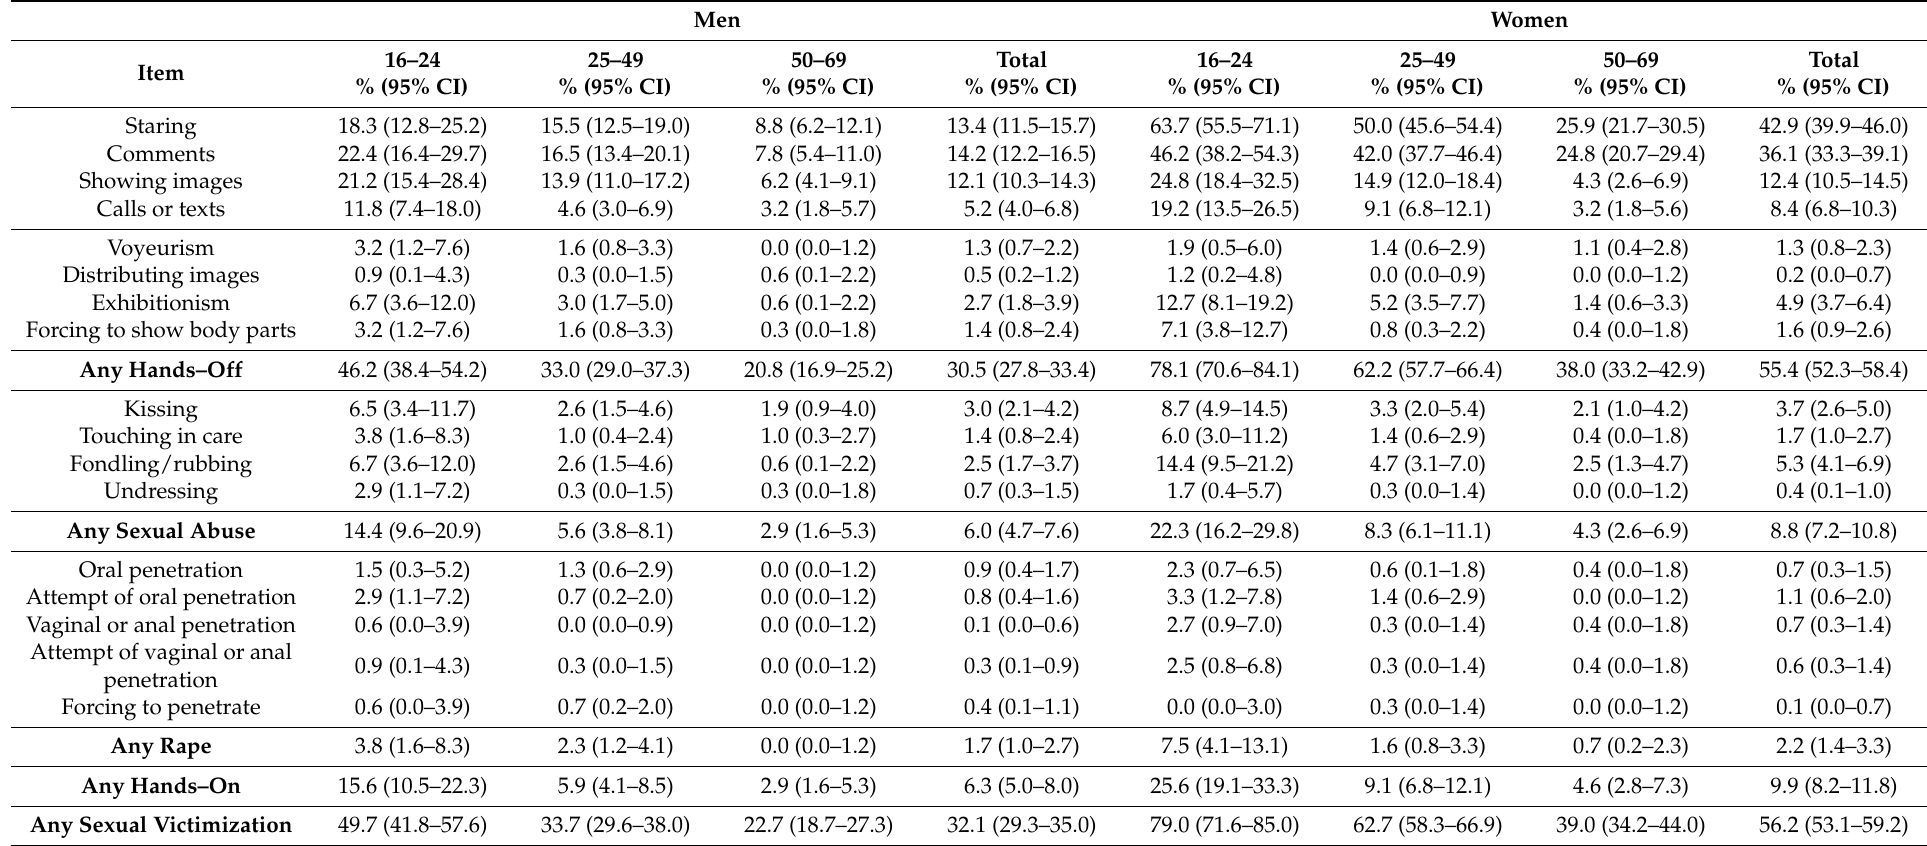
Table 4. Detailed and grouped weighted 12-month prevalence estimates sexual victimization, by sex and